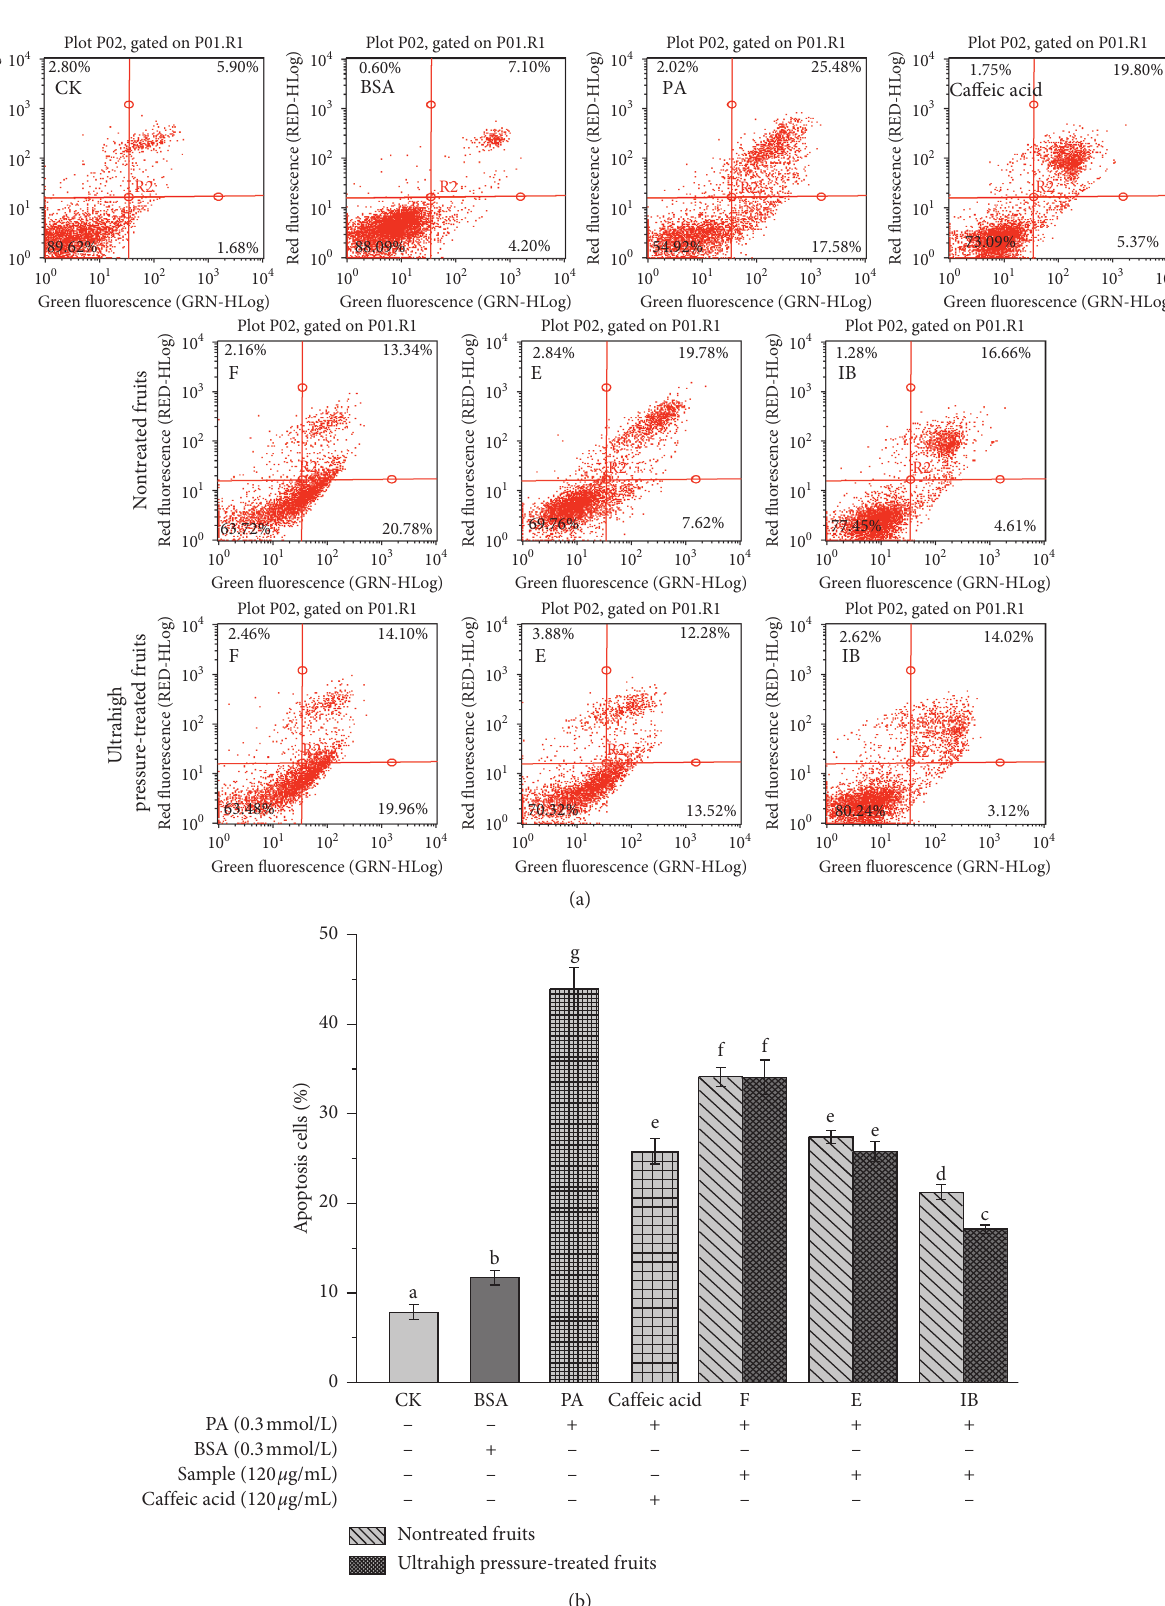
Figure 3: The inhibitory effects of phenolic fractions from oil palm fruits with or without ultrahigh pressure treatment and caffeic acid on PA-induced cell apoptosis: (a) flow cytometry analysis, (b) the relative apoptosis rate of different groups. Data are expressed as mean ± SD ( n � 3). In Figure 3(b), mean values with different letters are significantly different ( p < 0 . 05). CK: control group; BSA: BSA/NaOH complex solution; PA: PA/BSA complex solution; “F” free phenolic fraction; “E” esterified phenolic fraction; “IB” insoluble-bound phenolic